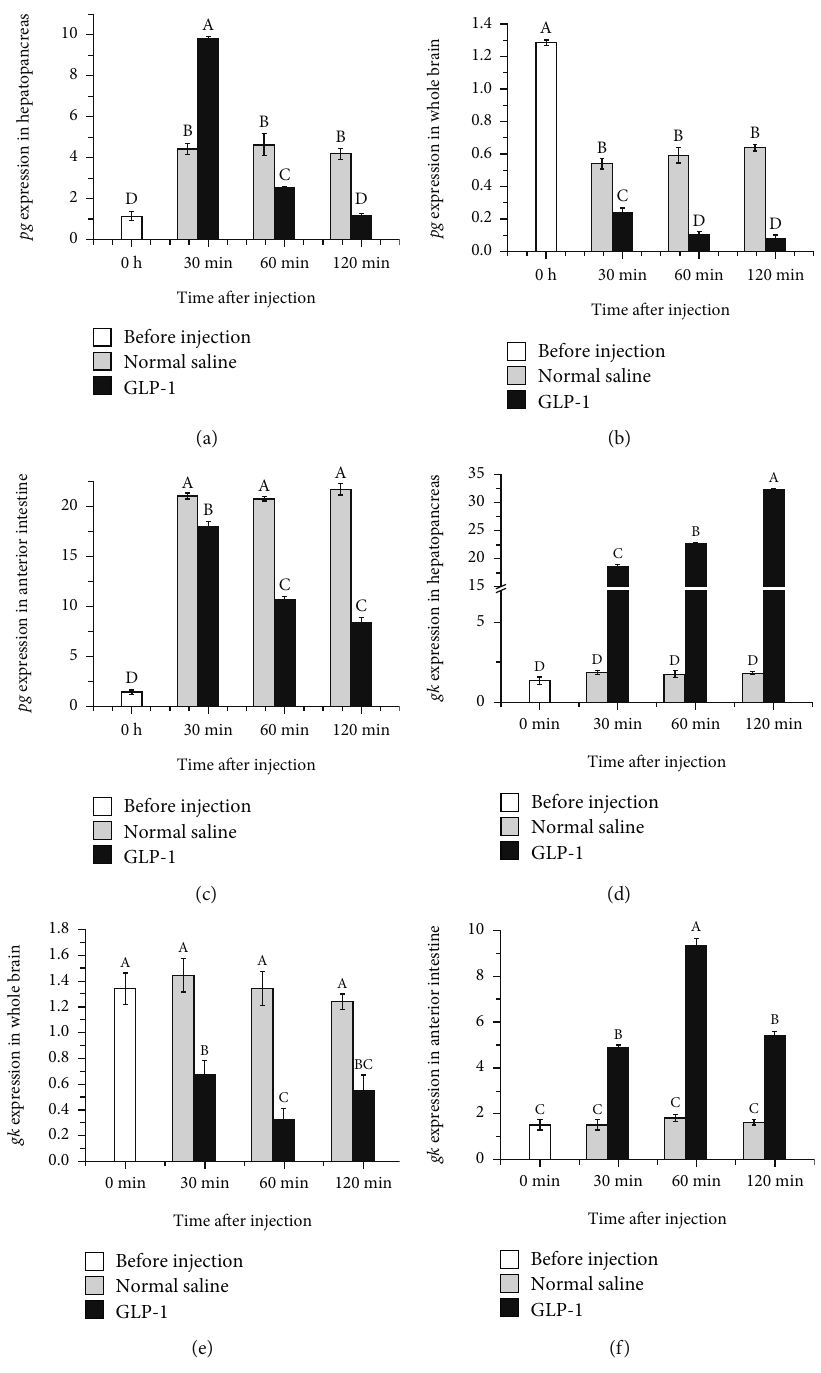
Figure 6: The e ff ects of GLP-1 injection on pg and gk gene expressions in the hepatopancreas, whole brain, and anterior intestine tissues at di ff erent time points. Di ff erent uppercase letters indicate the values with signi fi cant di ff erences ( P < 0 : 05